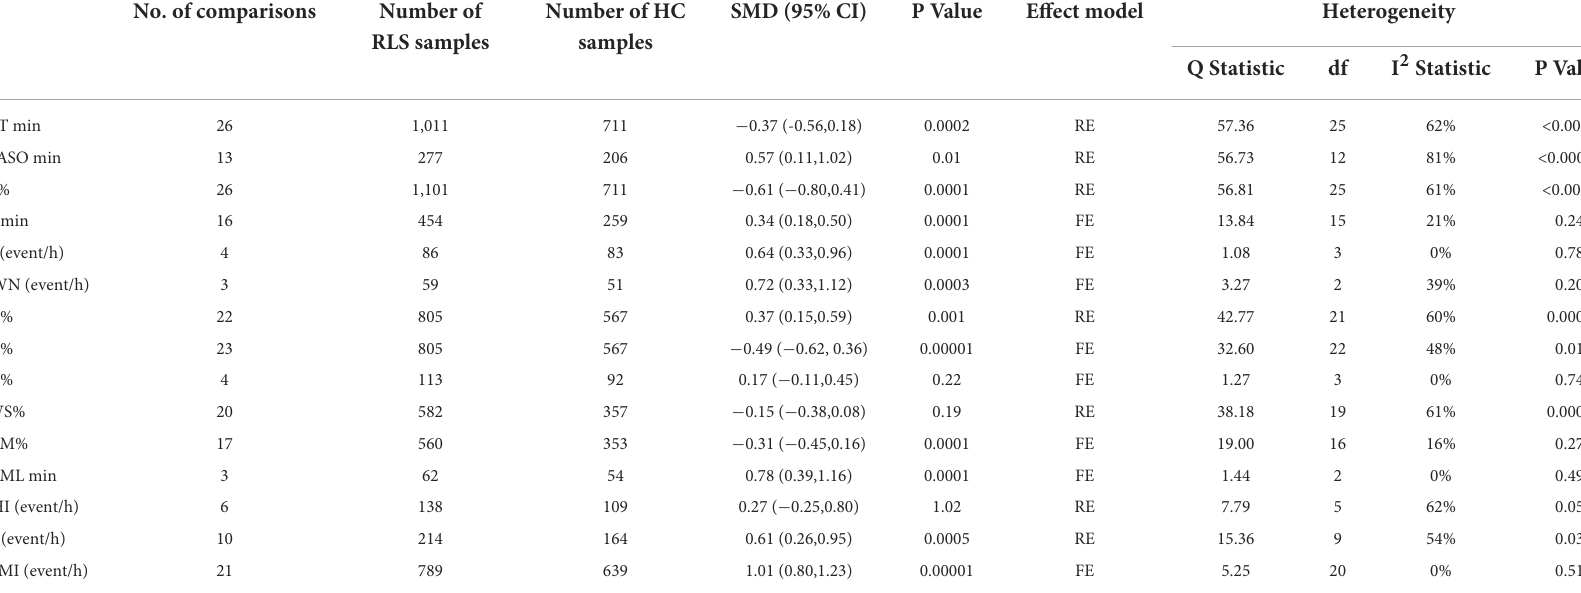
TABLE 3 Summary of meta-analysis comparing patients with Restless Legs Syndrome (RLS) patients and healthy controls